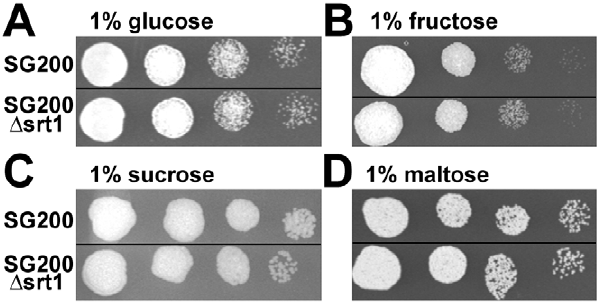
Figure 2. srt1 deletion does not affect U.maydis growth in axenic culture. Growth of SG200 D srt1 on glutamine minimal media containing the monosaccharides (A) glucose or (B) fructose or the disaccharides (C) sucrose or (D) maltose is not reduced compared to the SG200 wild-type strain. Cultures from liquid glutamine minimal medium (1% glucose) were spotted in a series of 10-fold dilutions on the media indicated.